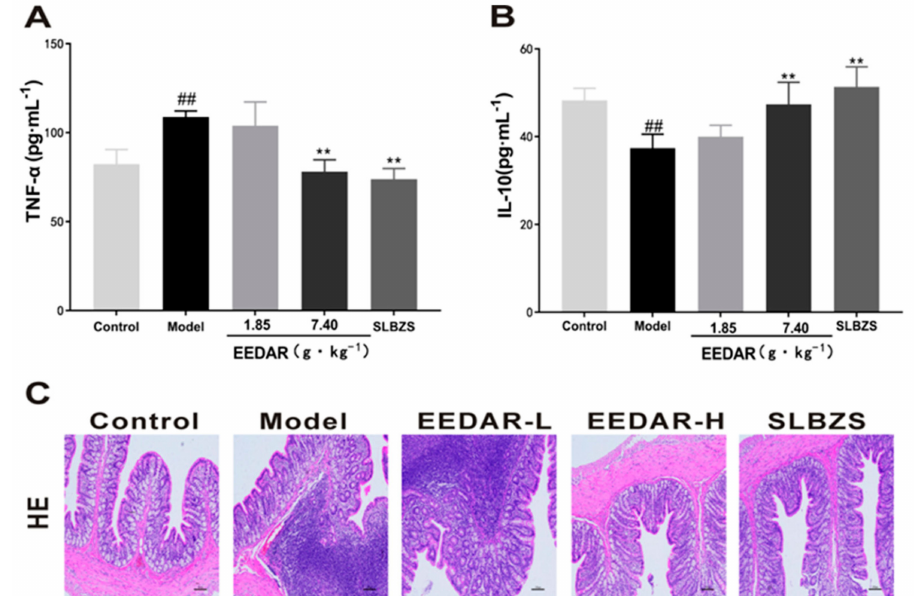
Figure 2. E ff ect of EEDAR on inflammation and the colons of spleen deficiency diarrhea rats ( n = 10). The levels of TNF- α ( A ) and IL-10 ( B ) in serum were determined by ELISA. Representative images of the HE-stained sections (200 × magnification) from the colons ( C ) indicated di ff erent pathological changes in spleen deficiency diarrhea rats when treated with EEDAR-L (1.85 g · kg − 1 ), EEDAR-H (7.40 g · kg − 1 ) and SLBZS. Values represent means ± SEM. ## p < 0.01 vs. Control; ** p < 0.01 vs.